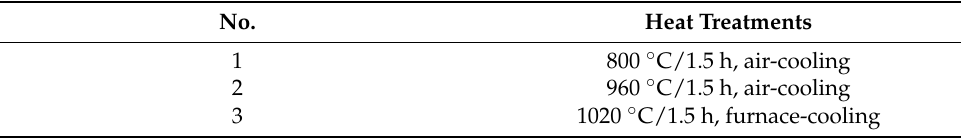
Table 2. Detailed heat treatments for Ti-6321 alloy. No.